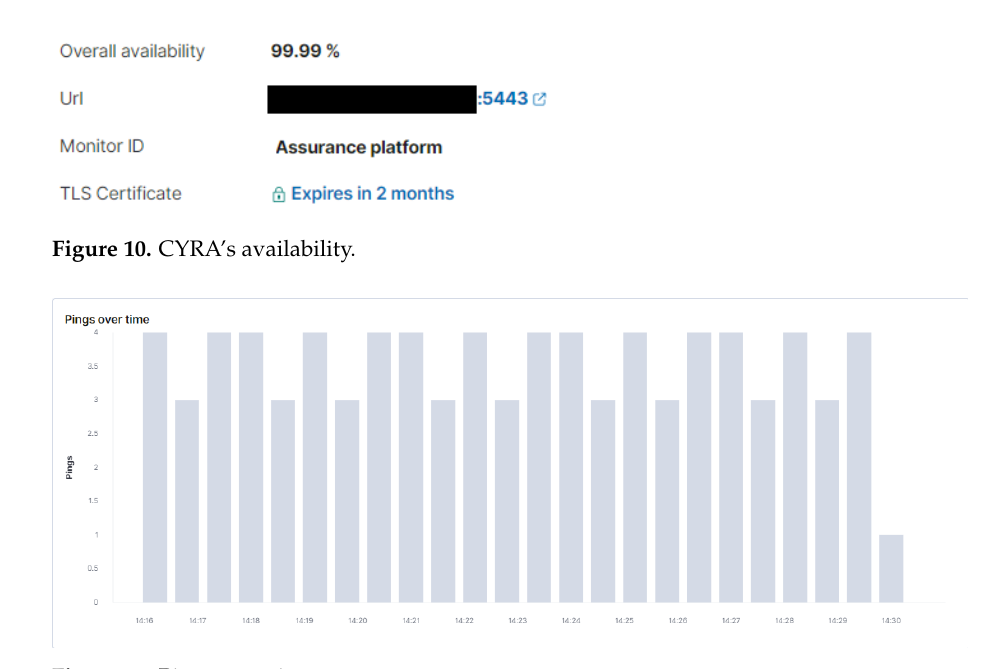
Figure 11. Pings per